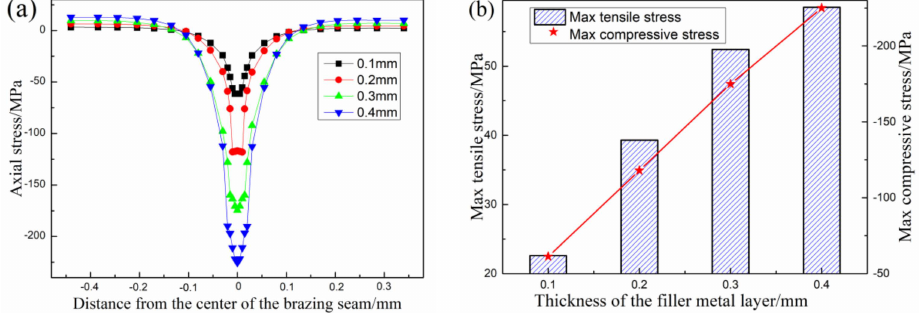
Figure 4. Axis stress ( σ y ) distribution of the SiC ceramic joints with di ff erent thickness of filler metal: ( a ) distribution on the edge of joint, ( b ) Maximum tensile and compressive